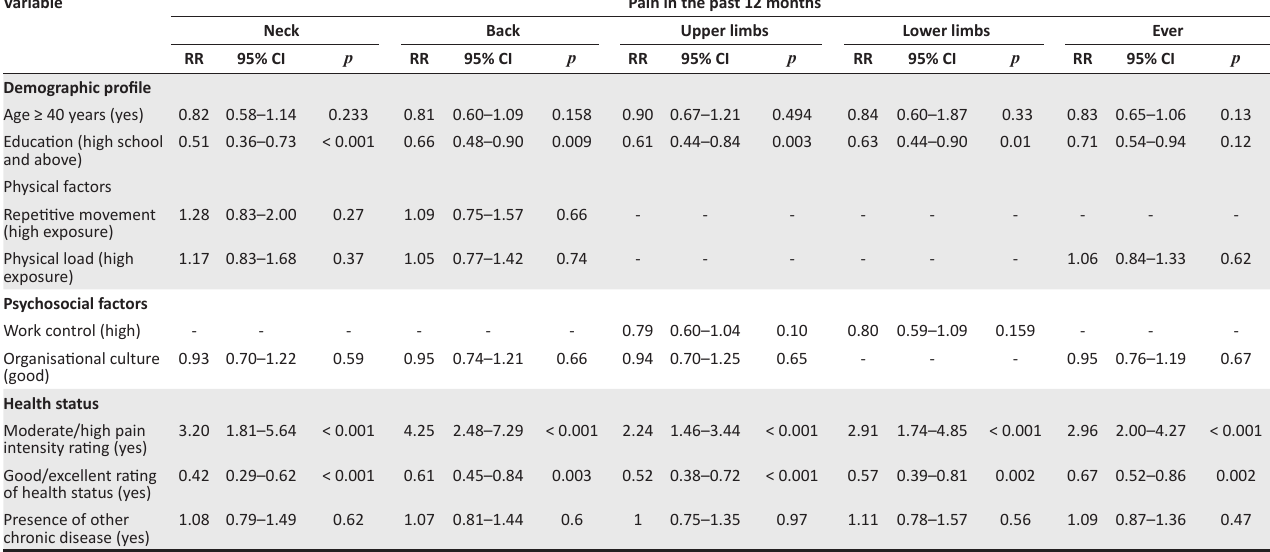
TABLE 5: Multivariable logistic regression models of demographics, physical and psychosocial factors, health status and pain in the past 12 months amongst female mine workers employed in a South African gold mine ( n = 225).